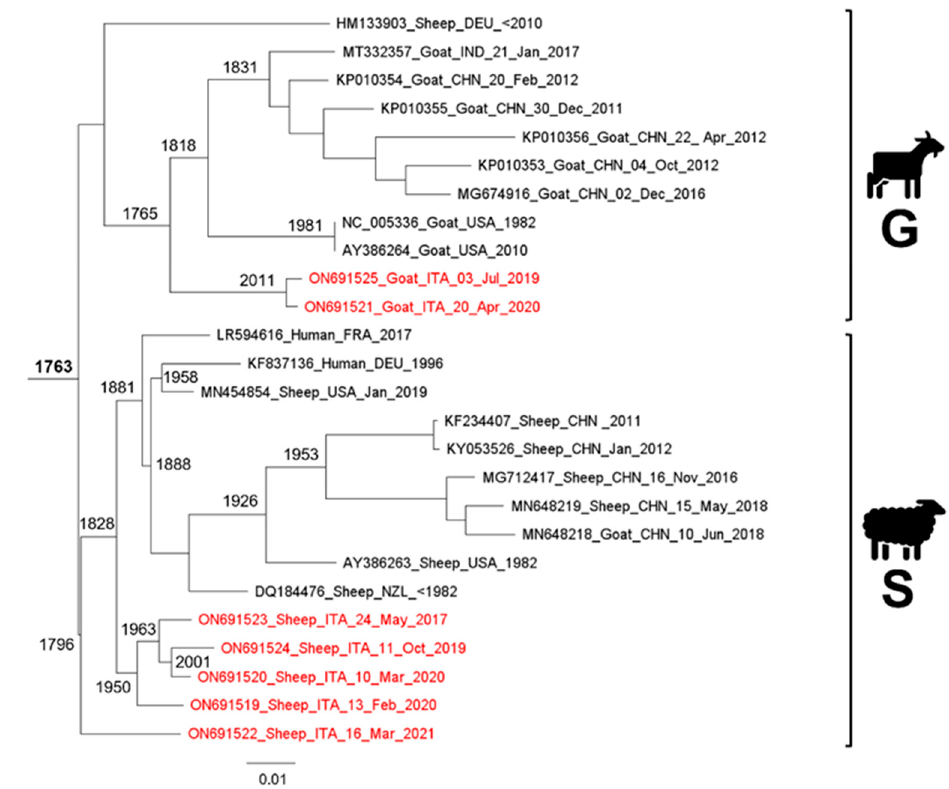
Figure 1. Bayesian phylogenetic tree based on all ORF virus whole genomes used in the present study. The Italian whole genomes from Sardinia which were obtained in the present study are indicated with a red font. All the nodes of the tree are fully supported and values of posterior probabilities for all the nodes are = 1. Capital letters on the right indicate the genetic clusters described in the text. The year indicated at the main node represent the coalescent time of the cluster and was inferred according to the molecular dating estimates (years before 16 March 2021) reported in the ultrametric tree (Figure A1).